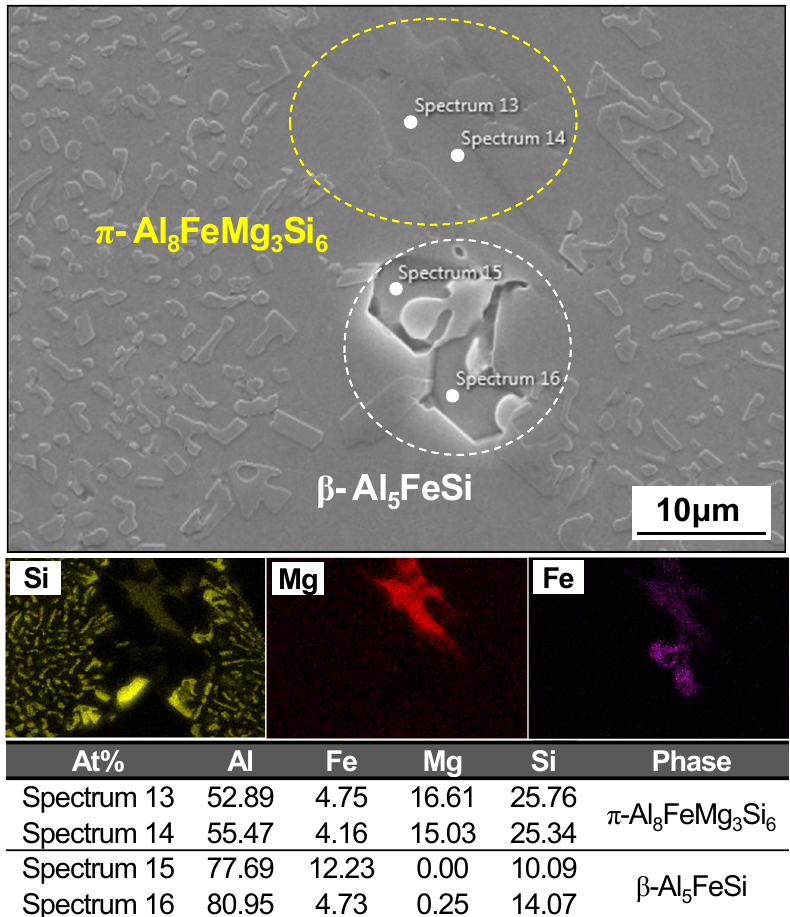
Figure 7. The composition of intermetallics in the CPC A356 specimen heat-treated at 180 ◦ C for 6 h. Figure 8 shows SEM images of π -Al 8 FeMg 3 Si 6 and β -Al 5 FeSi intermetallics in CPC A356 specimens at different T5 heat treatment conditions. After 9 h of T5 heat treatment at 200 ◦ C, those intermetallics were still observed in the sample.